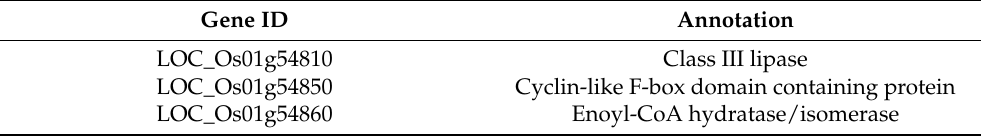
Table 2. Annotations of candidate genes in the region covering CHA-1 based on the MSU7